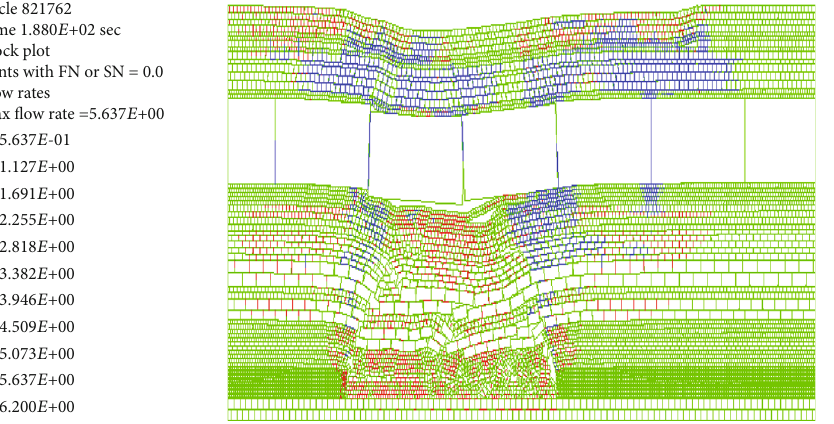
Figure 9: The fl ow distribution in initial caving of #3 key stratum.